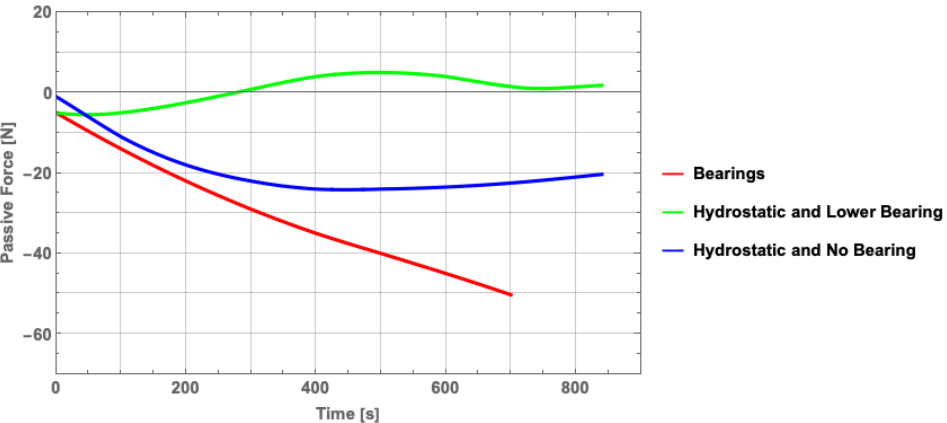
Figure 8. Average passive force progression from five repetitions with: ( red ) sealed bearings as both upper and lower guides; ( blue ) hydrostatic upper guide and bearing lower guide; ( green ) hydrostatic upper guide and no lower